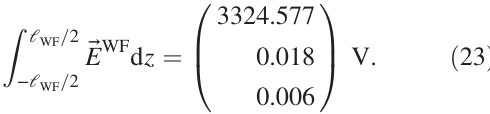
[see also Eq. (14) EDM